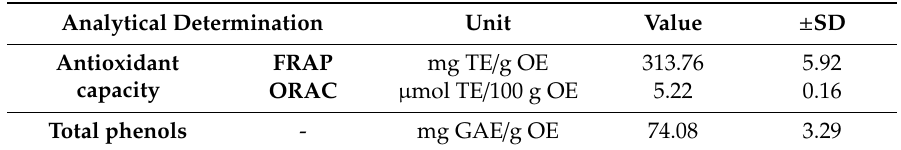
Table 2. Quantification of antioxidant capacity and total phenols in oleoresin extracted by SC-CO 2 from the microalga Haematococcus pluvialis using various analytical